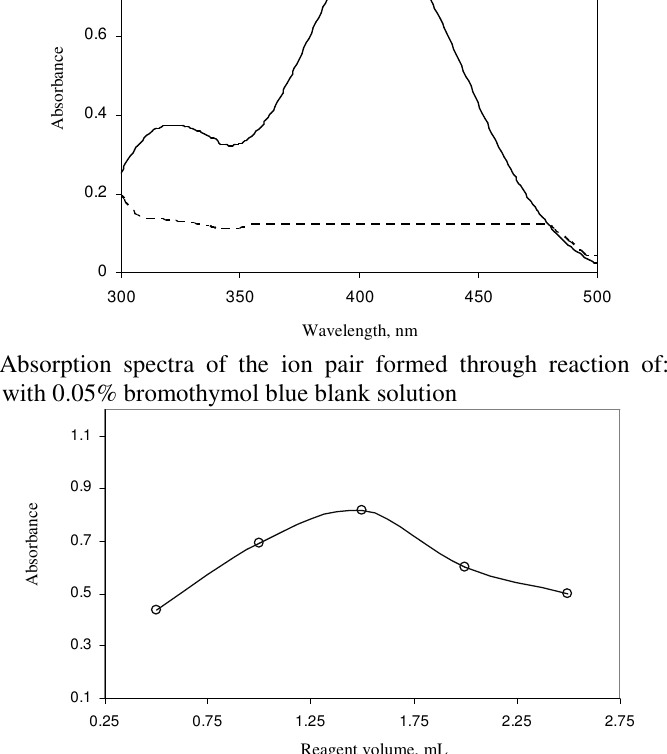
Figure 6. Effect of volume of 0.05% bromothymol blue on the reaction of bromothymol blue with 800 µ g mL -1 gabapentin